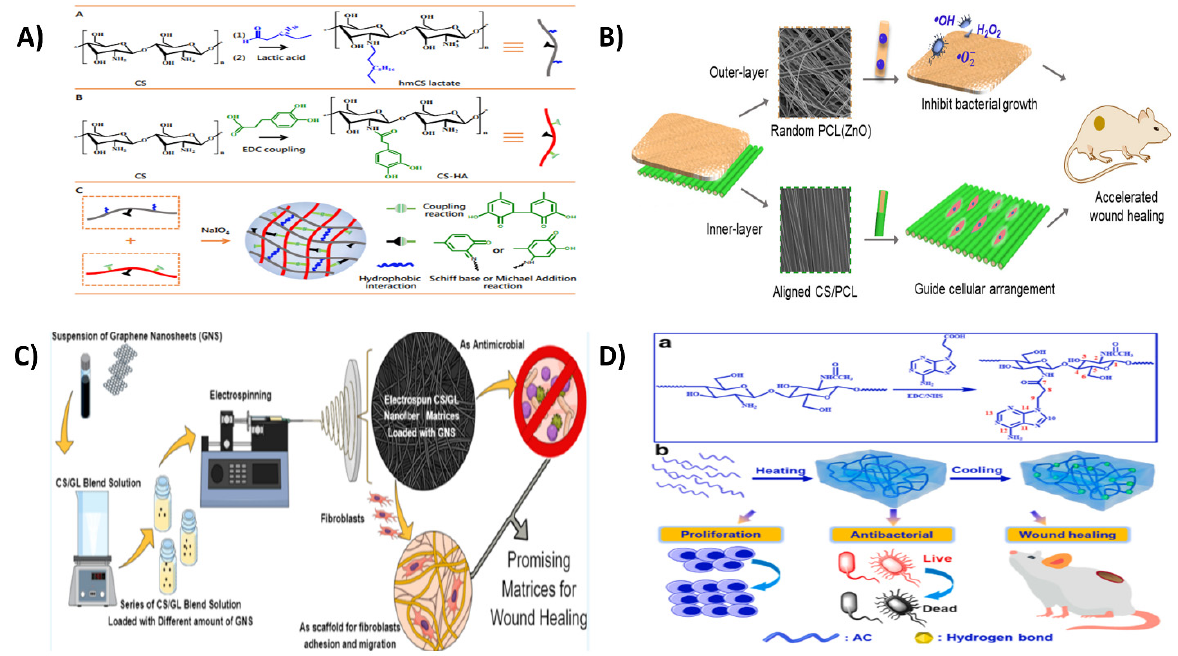
Figure 6. ( A ) Sutureless wound closure with anti-infective and pro-coagulator chitosan-mediated hydrogel tissue adhesives, reproduced with permission from [281], copyright ACS publications 2020; ( B ) Enhanced wound healing with electrospun ZnO-impregnated chitosan/PCL bilayer membranes featuring a spatially tailored structure. Reproduced with permission from [284], copyright Elsevier 2022; ( C ) Graphene-reinforced electrospinning-based chitosan/gelatin nanocomposite scaffolds having antibacterial and wound-healing properties [285]; ( D ) Chitosan-based hydrogels for wound repair that are injectable, self-healing, and antimicrobial. Reproduced with permission from [286], copyright Elsevier 2022.